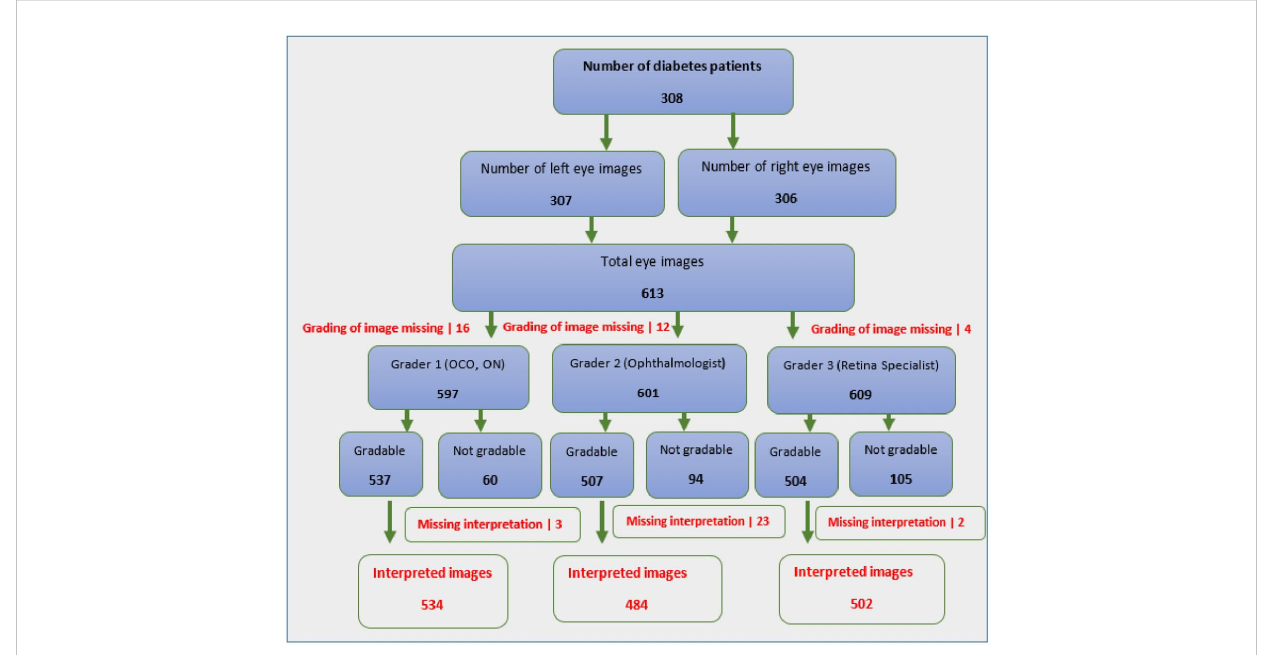
FIGURE 1 Schematic diagram of eye images graded and interpreted by graders 1, 2 and